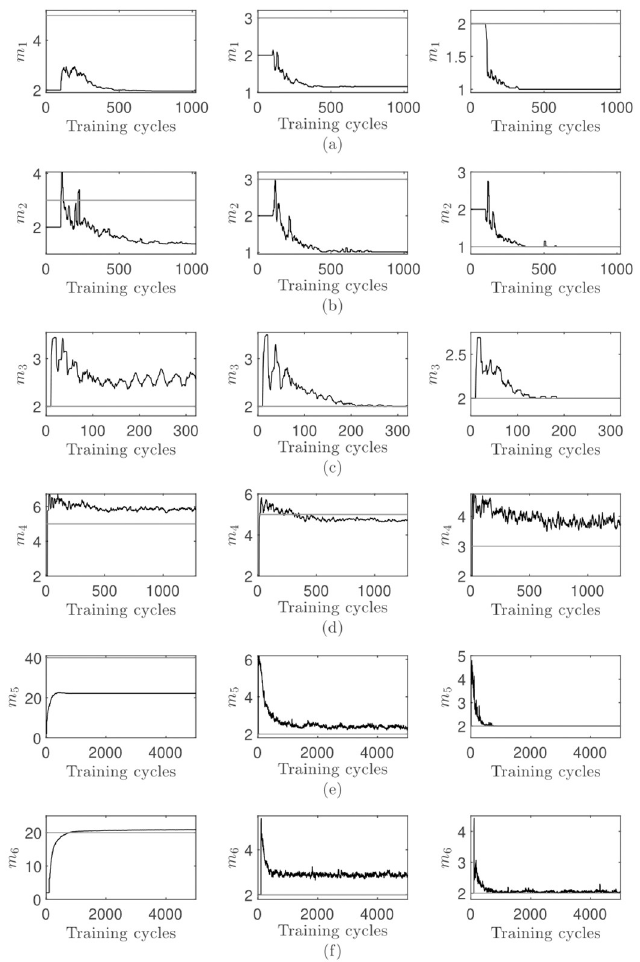
Fig 7. Visualization of the results achieved with the online percentage of the total variance criterion. The first plot in each row has an accuracy factor of η 1 = 0.01, the middle plot η 2 = 0.025 and the right plot η 3 = 0.05: (a-f) shows the results obtained on each data set, with the data set order corresponding to Table 4. Each data point in each time series is the mean value of all 100 repetitions. The horizontal reference line represents the optimal dimensionality.